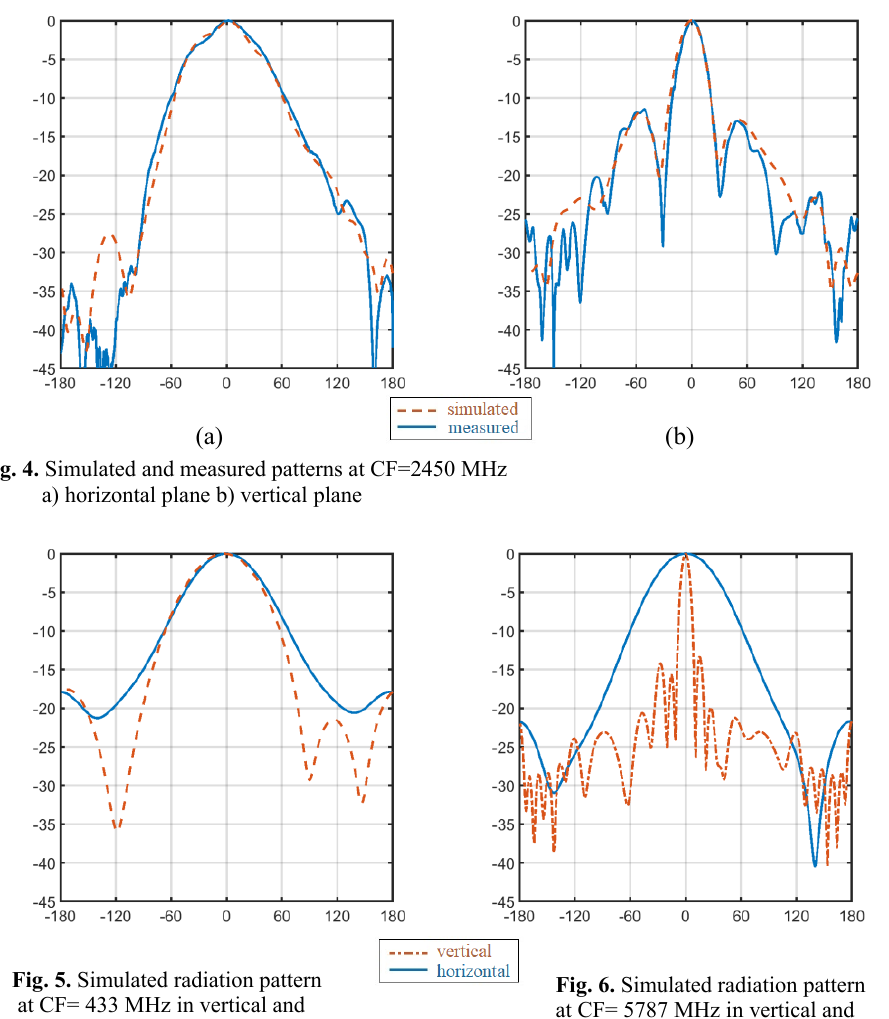
Fig. 6. Simulated radiation pattern at CF= 5787 MHz in vertical and horizontal